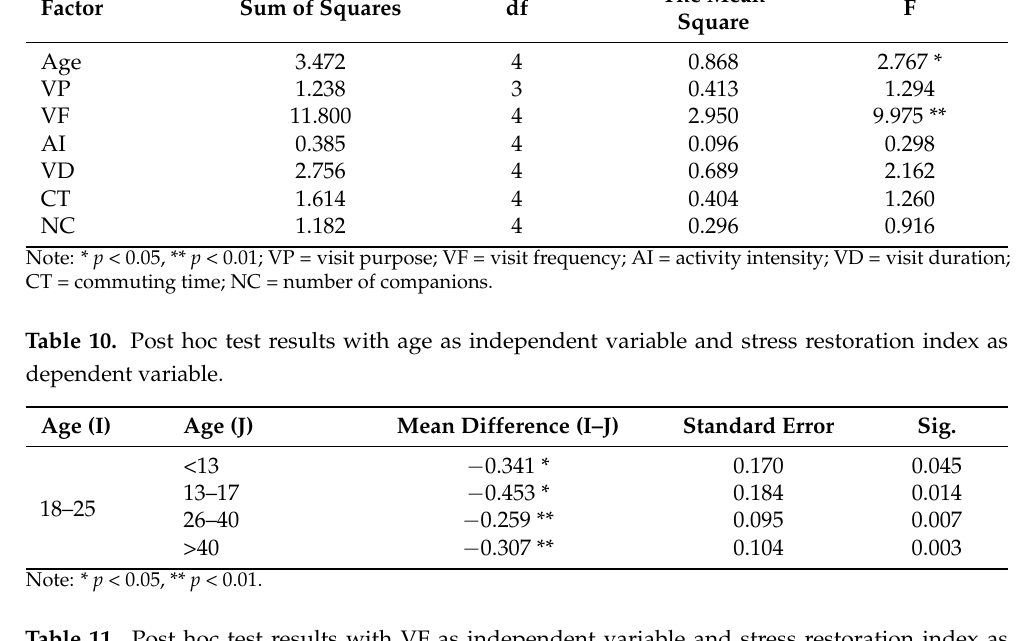
Table 11. Post hoc test results with VF as independent variable and stress restoration index as dependent